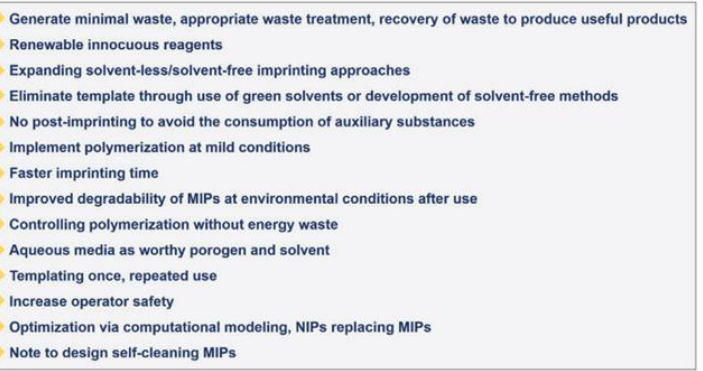
Figure 7. The fourteen principles of green molecular imprinting expressed as the mnemonic device “GREENIFICATION.” (Reprinted with permission from Ref. [132]. Copyright 2021 John Wiley “GREENIFICATION.” ( Reprinted with permission from Ref. [132]. Copyright 2021 John Wiley and and Sons.)